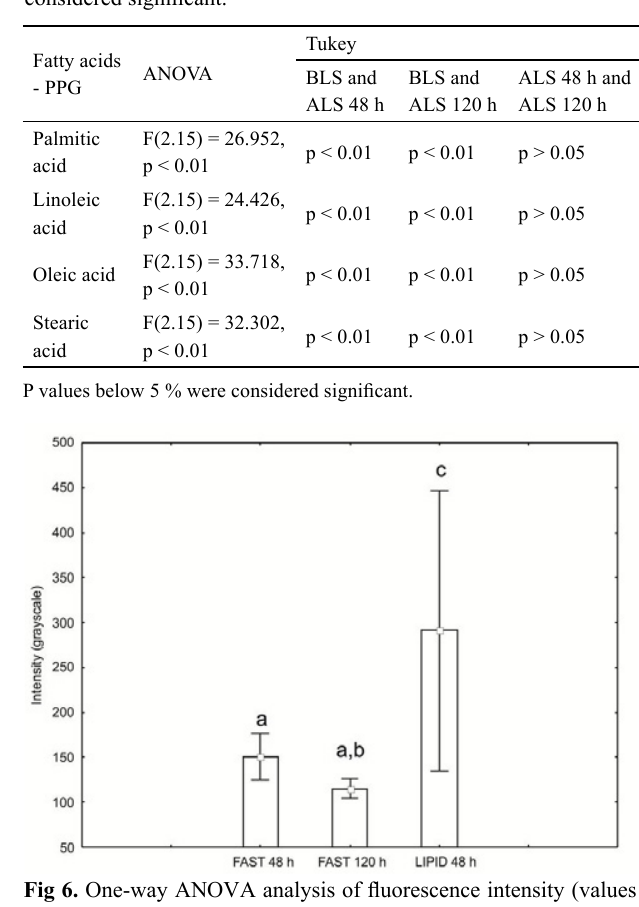
Table 4 . One-way ANOVA of fatty acid content in the postpharyngeal gland (PPG) of A. sexdens rubropilosa workers between groups before lipid supplementation (BLS) and after lipid supplementation (ALS) for 48 and 120 h. P values below 5 % were considered significant.